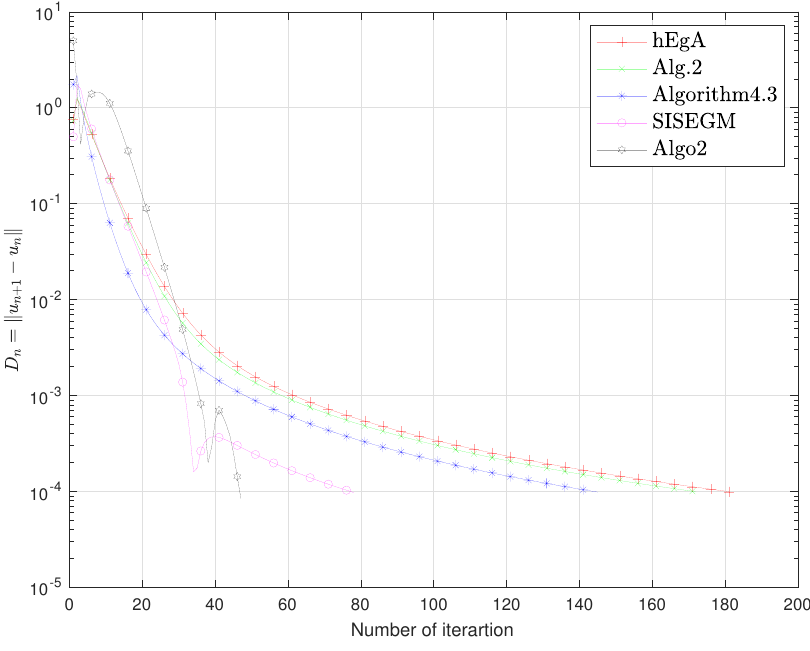
Figure 13. Example 2: Numbers of iterations are 181, 172, 145, 78, 47